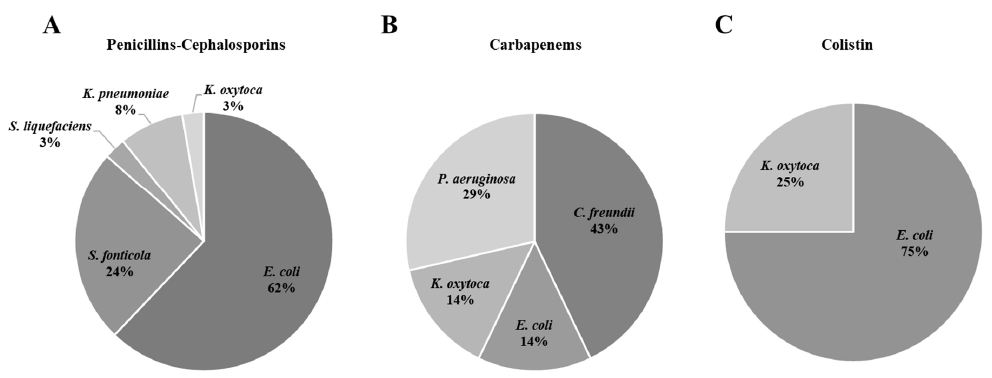
Figure 3. Genus distribution of isolated Gram negative target resistant bacteria. ( A ) Penicillins- Cephalosporins; ( B ) Carbapenems and ( C )